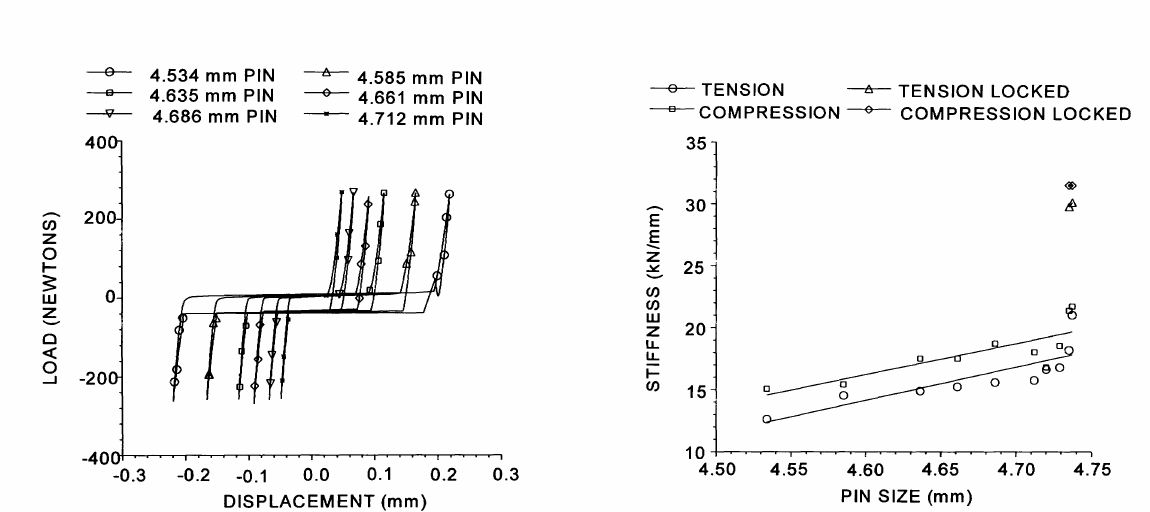
FIGURE 6 Plot of joint stiffness in tension and com pression as a function of pin